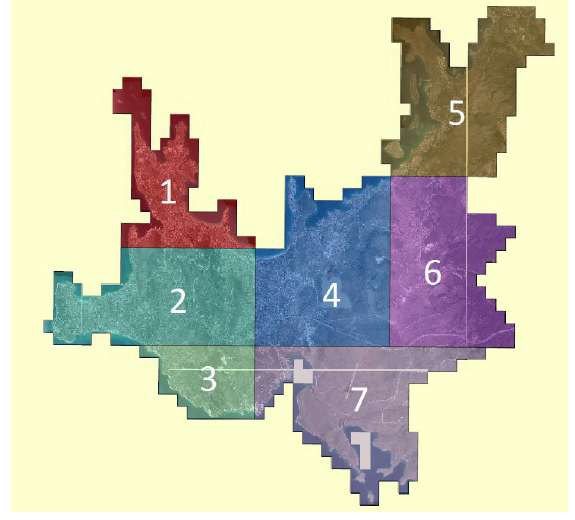
Figure 5. Photogrammetric blocks generated for the area.